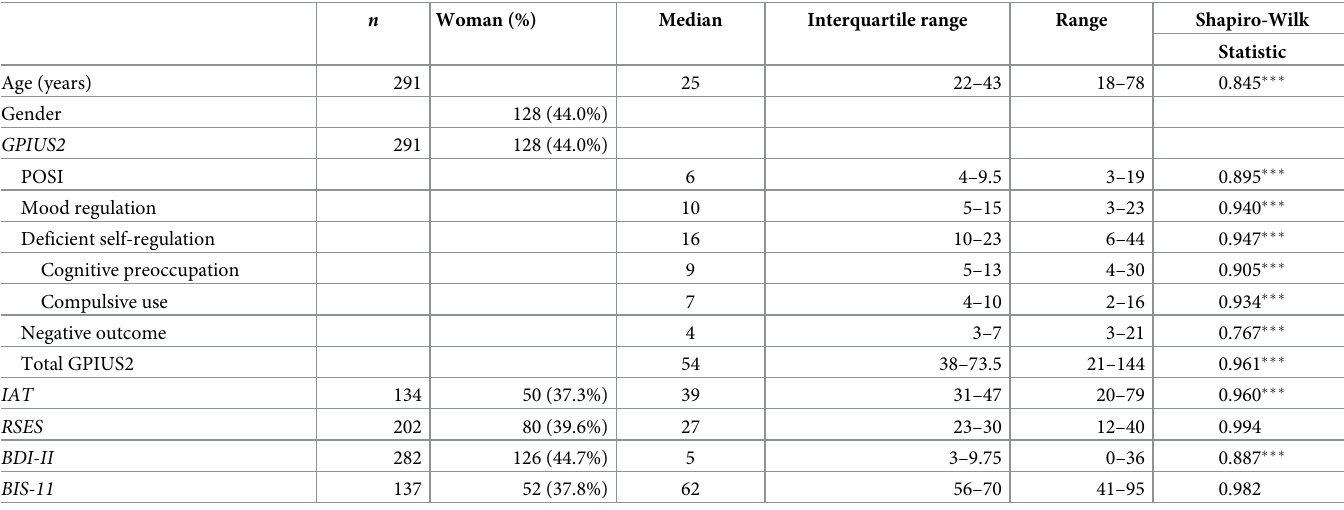
Table 1. Descriptive statistics of the participants and the